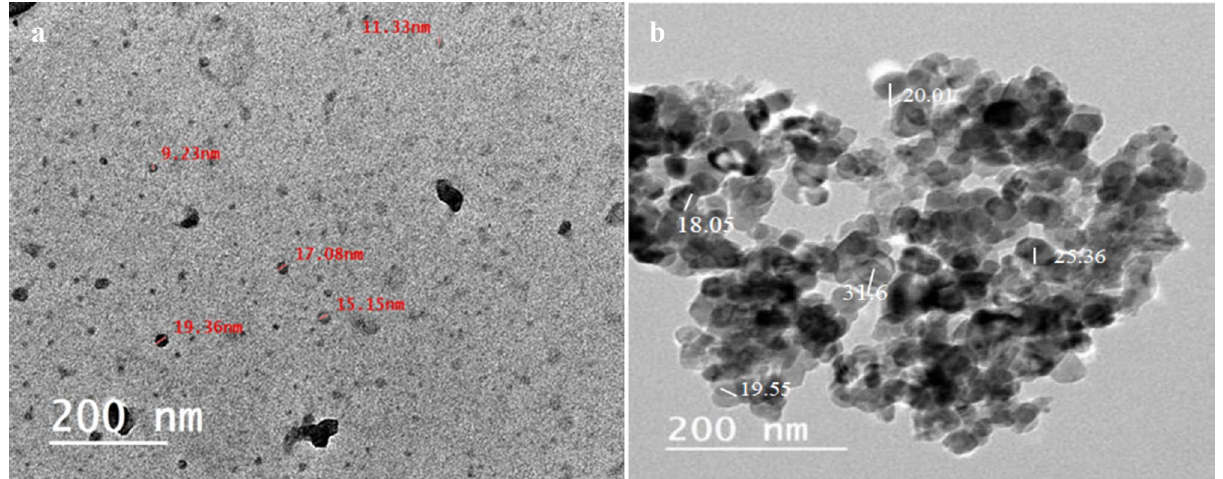
Figure 3. TEM of ( a ) prepared DSNP, ( b ) as received TiO 2 NP.